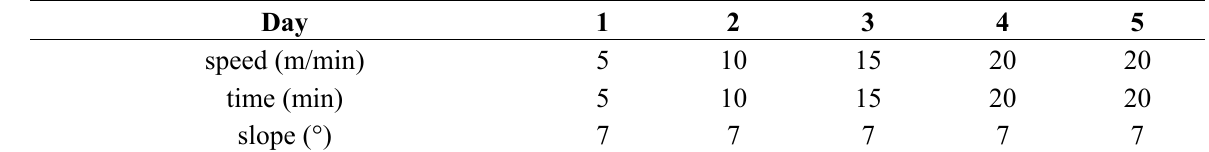
Table 3. Treadmill exercise for